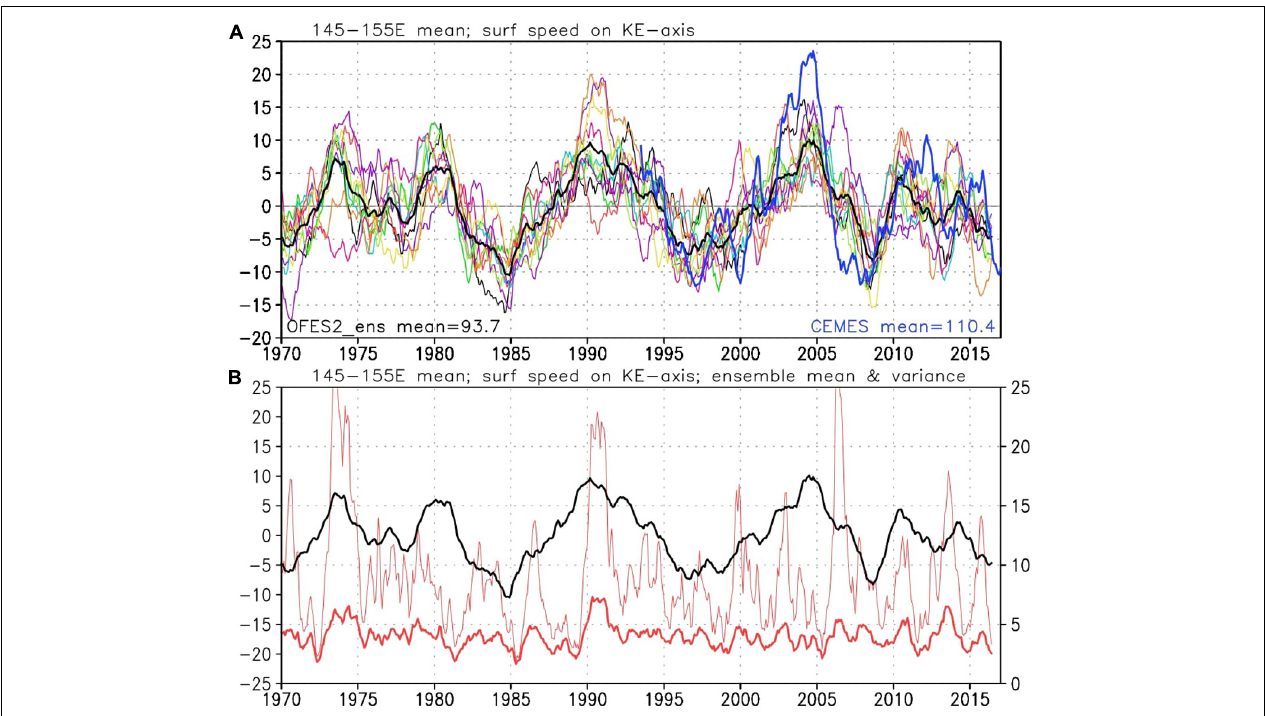
FIGURE 4 | Time series of the Kuroshio Extension jet speed at 2.5-m depth on its axis averaged in 145 ◦ –155 ◦ E for panel (A) each ensemble member (thin curves), the ensemble mean (thick black curve), and observation (thick blue curve). The temporal means are estimated for the period from July 1993 to June 2016, the common period for the model and observation data, and shown in the left-bottom (model) and right-bottom (observation) of the panel (A) . (B) For ensemble mean (thick black curve, left axis) and ensemble spread (thick red curve, right axis). Red thin curve indicates a 95% confidence interval of the ensemble spread (only upper boundary is shown) following Leroux et al. (2018). Unit is cm s − 1 . A 13-month running mean is applied and the linear trend is